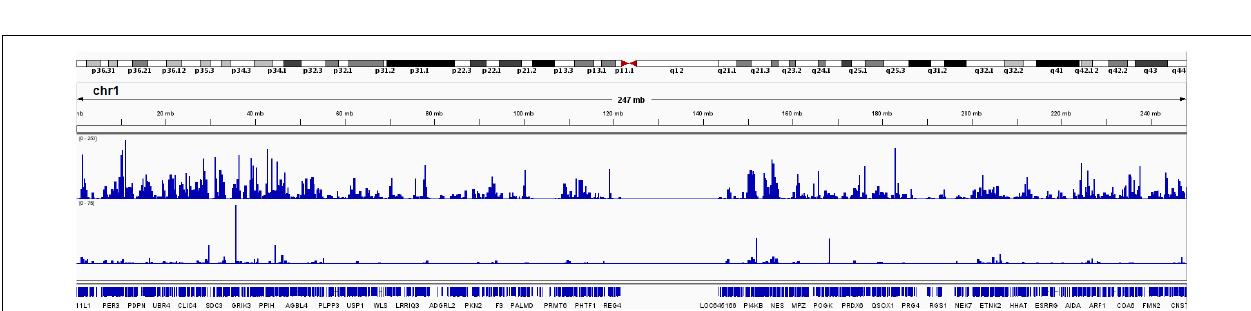
FIGURE 5 | RNA editing frequency for chromosome 1 measured in both GTEx and TCGA. The RNA editing frequency is computed as number of RNA editing events observed in a 10,000 nucleotide long moving window.